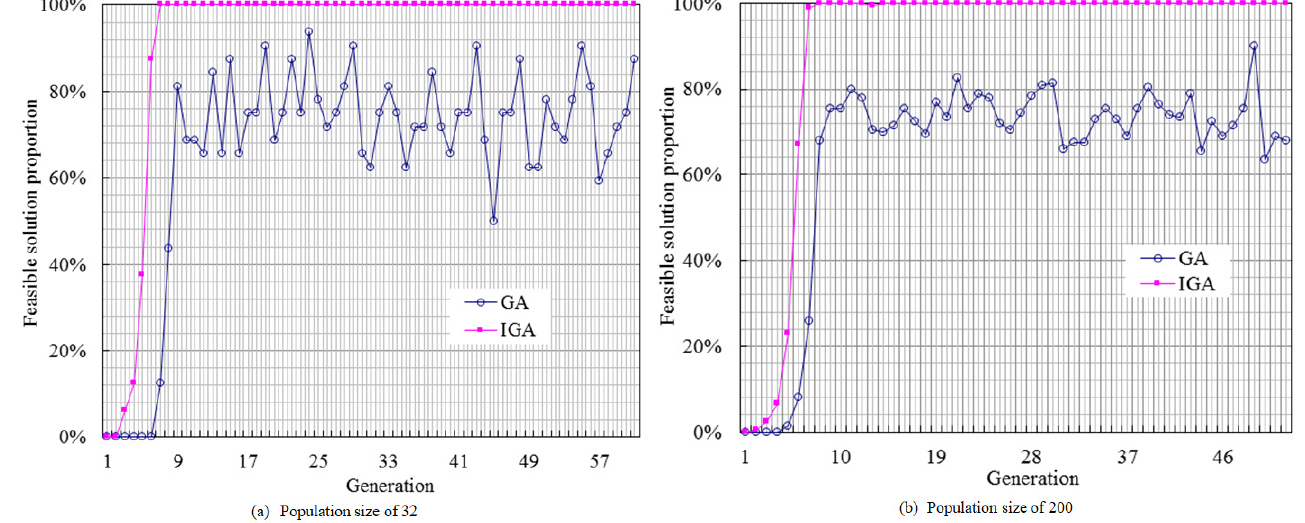
Figure 9. Graphs of proportion of feasible solutions against number of